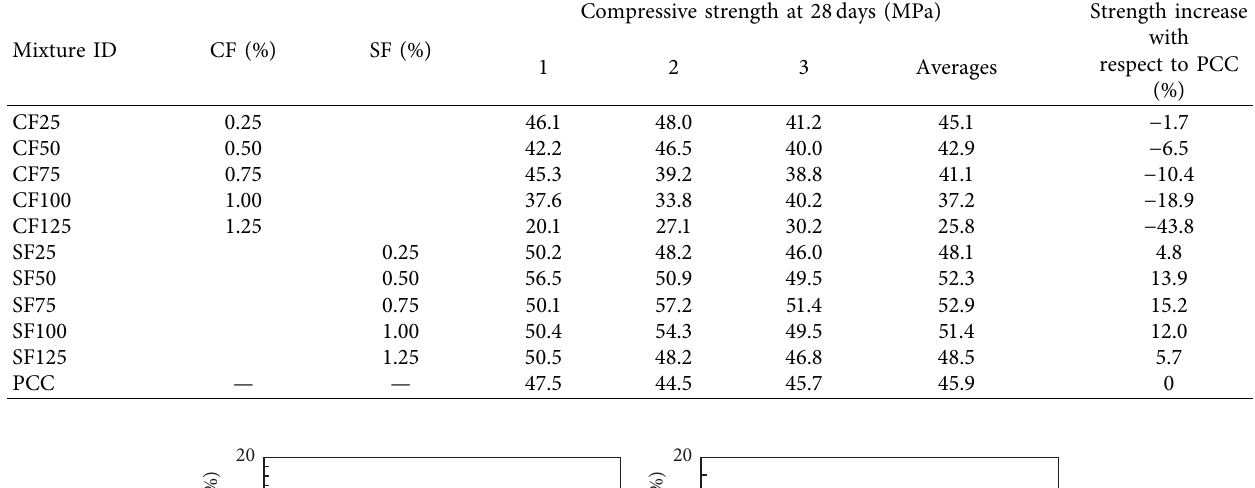
Table 4: Compressive strength test results of conductive CFRCM and SFRCM versus